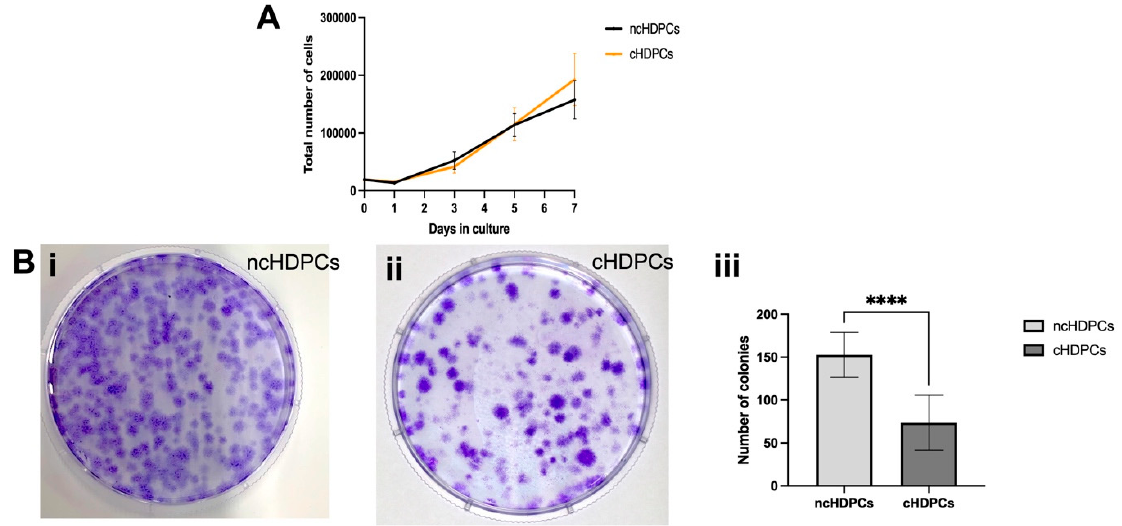
Figure 2. ( A ) Growth curves for ncHDPCs and cHDPCs (n = 5 each) over 7 days of culture. No significant differ- ences were observed between the two cell populations ( p = 0.8889). Error bars indicate mean ± SD. ( B ) Colony forming unit (CFU) efficiency of ncHDPCs and cHDPC. Representative images of crystal violet-stained colonies at 14 days ( i , ii ) are shown. ( iii ) Quantification of the average number of CFUs formed for ncHDPCs and cHDPCs (n = 5 each). A statistically significant difference was found in the colony forming efficiency between ncHDPCs and cHDPCs (**** p < 0.0001).